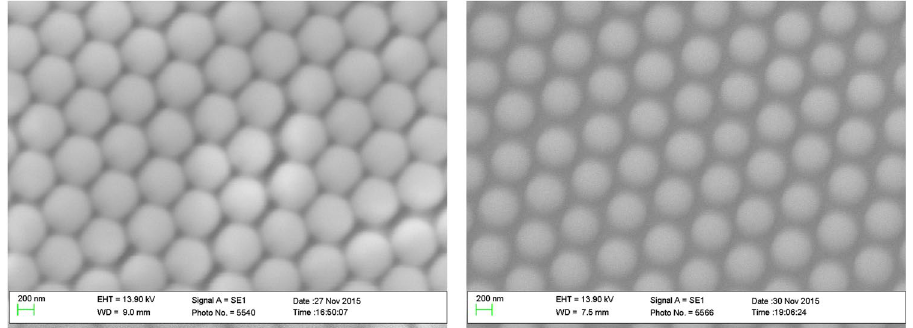
Figure 2. SEM images of the polystyrene sphere monolayer deposited on a Si (100) substrate before (left) and after (right)